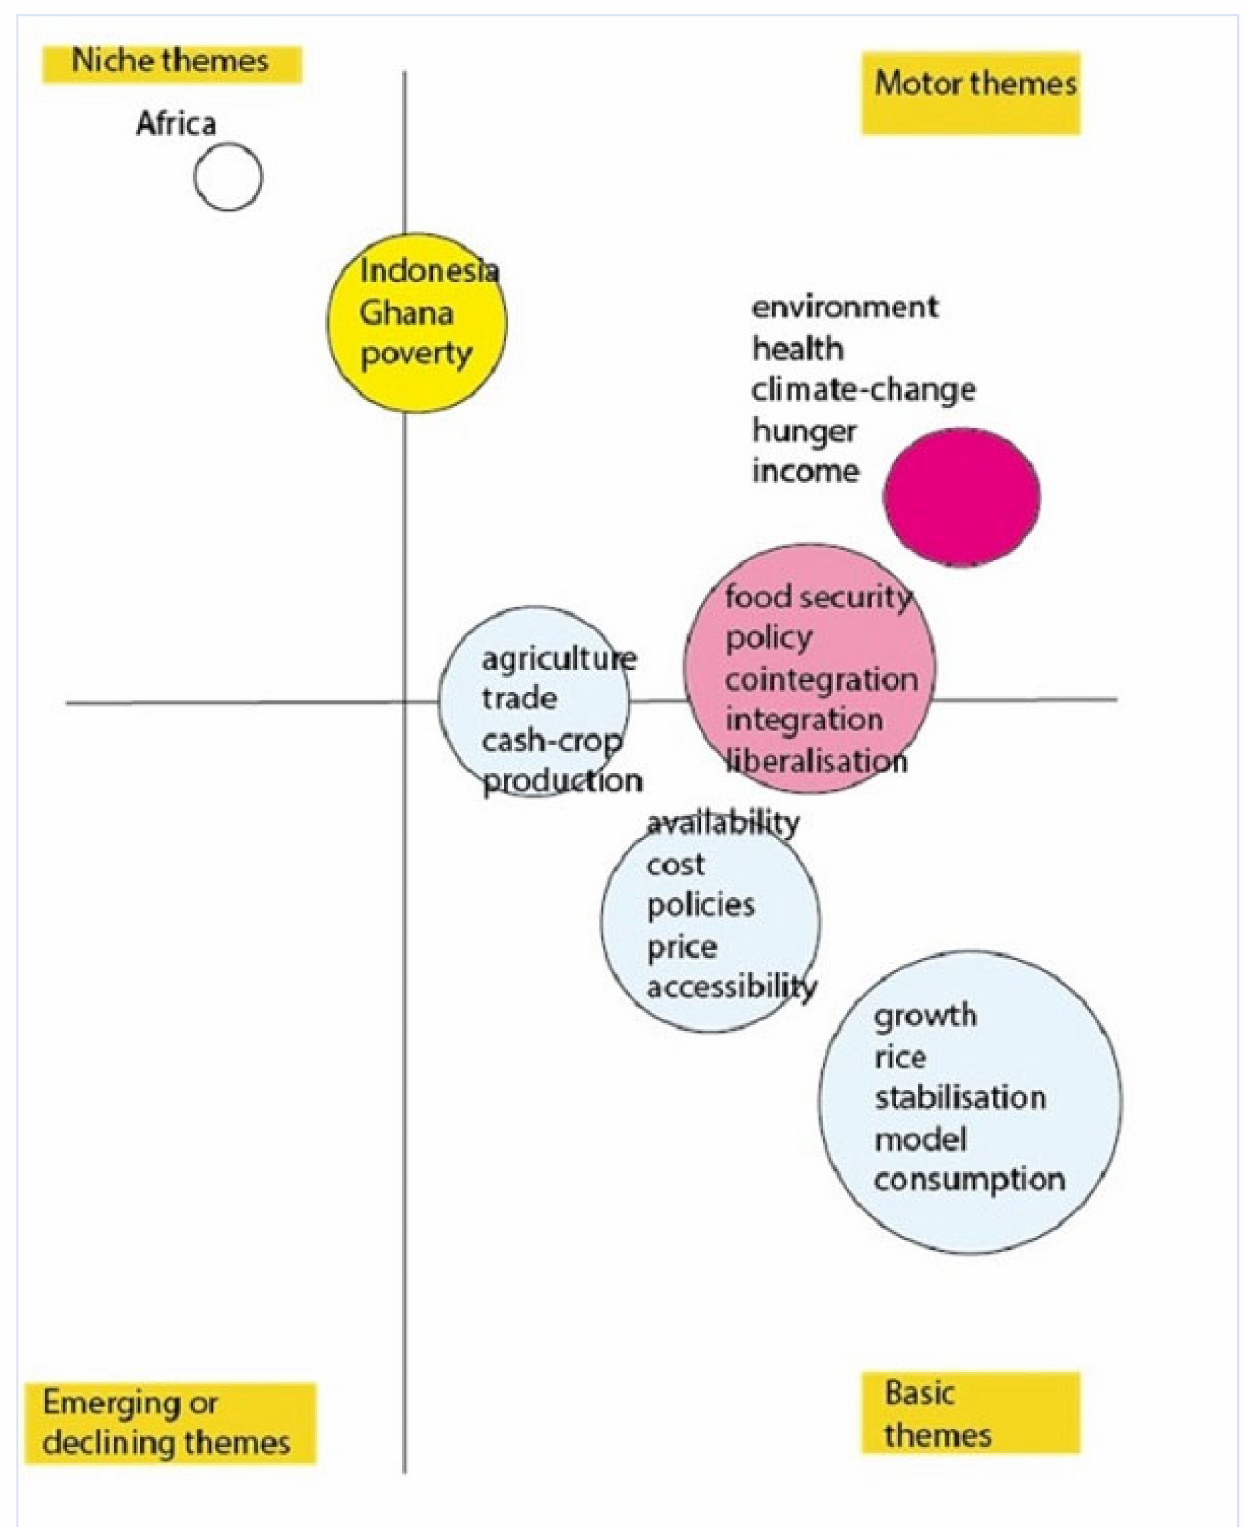
Figure 9. Strategic map of publications up to 2008. Source R studio